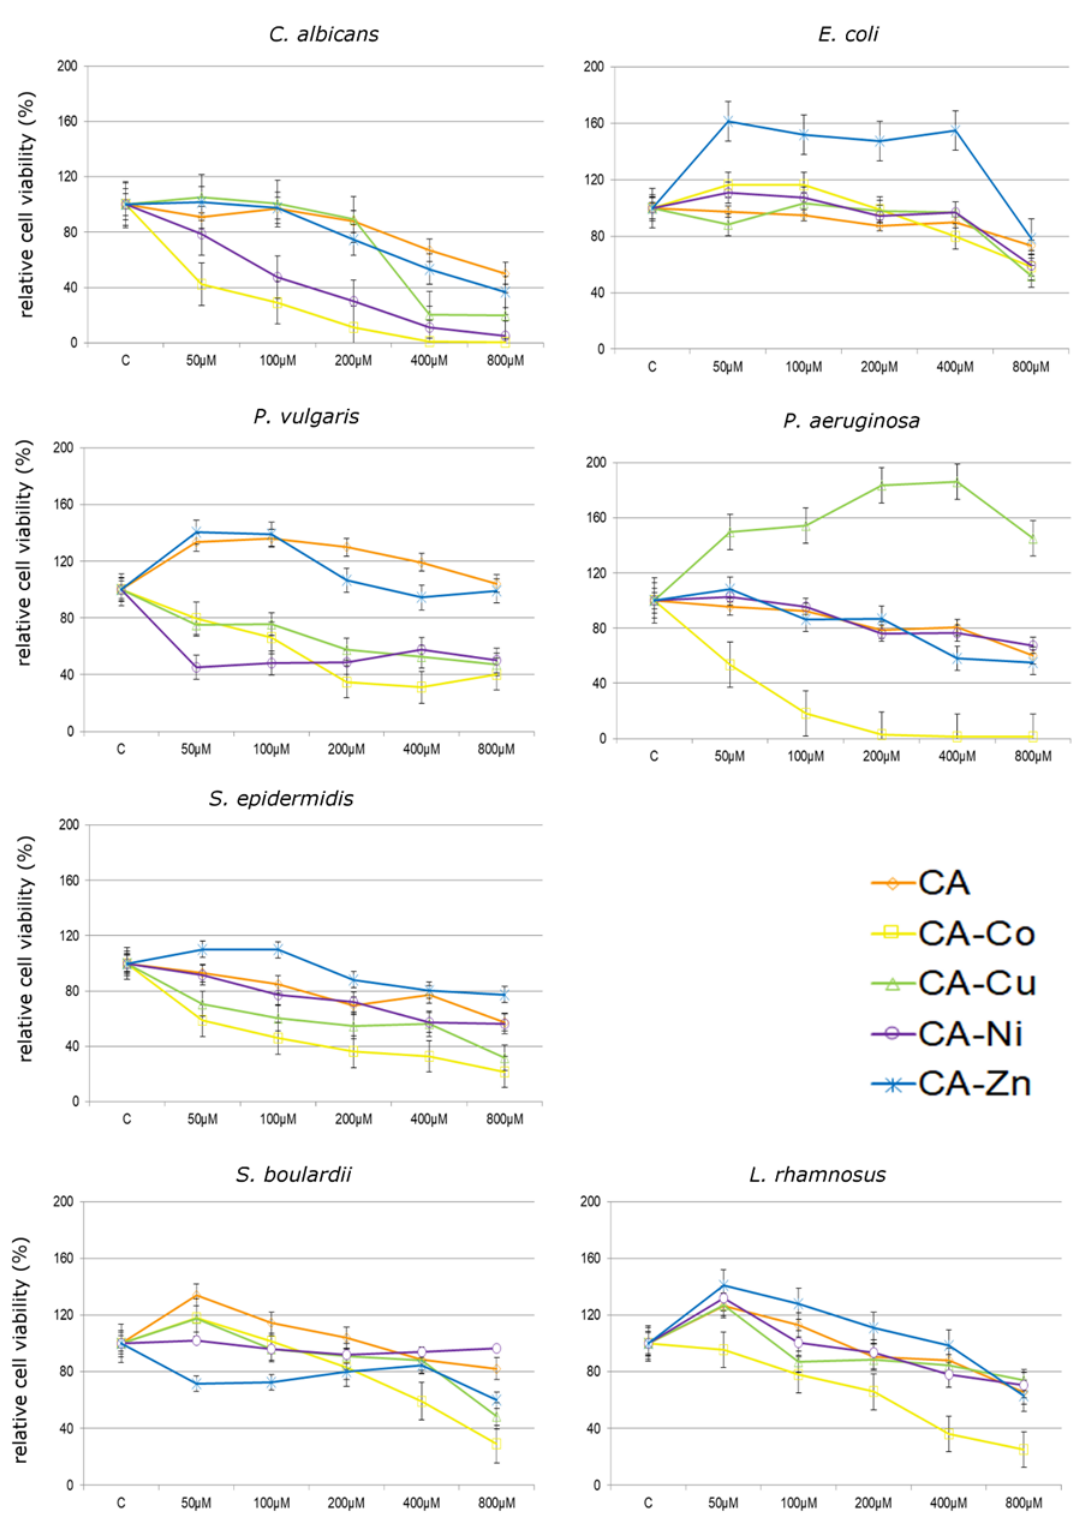
Figure 5. Cytotoxicity of cichoric acid (CA) and its complexes with Co (CA–Co), Cu (CA–Cu), Ni (CA–Ni) and Zn (CA–Zn) on fungi ( C. albicans and S. boulardii ) and bacteria strains ( E. coli , P. vulgaris , P. aeruginosa , S. epidermidis , L. rhamnosus ) expressed as relative cell viability (%) as compared to non-treated control (C). Each value on the graph is the mean of three independent experiments and error bars show the standard deviation